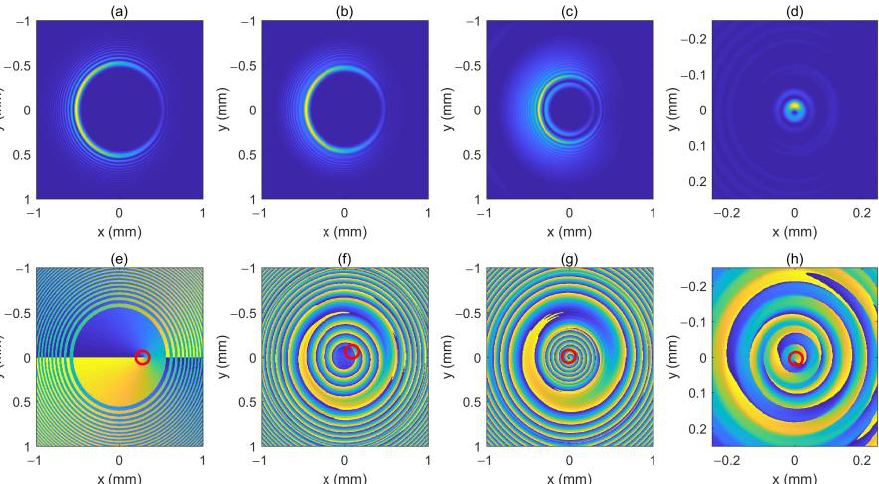
Figure 7. The intensity pattern and phase distribution of the LHCP component at different distances. ( b – d ) show the intensity pattern for z = 50 mm, z = 100 mm, and z = 200 mm, respectively; ( f – h ) show the phase distribution for z = 50 mm, z = 100 mm and z = 200 mm, respectively. The intensity pattern and phase distribution of the initial beam are also shown in ( a ) and ( e ). The center of the OV is marked with a red circle.